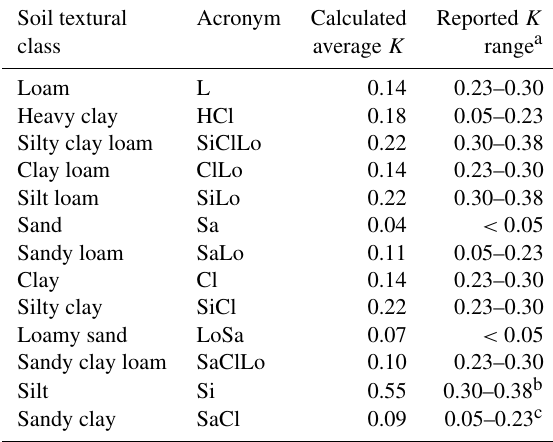
Table 4. Comparison between the average erodibility factor ( K ) calculated for each soil textural class in the SWAT dataset and val- ues reported in the